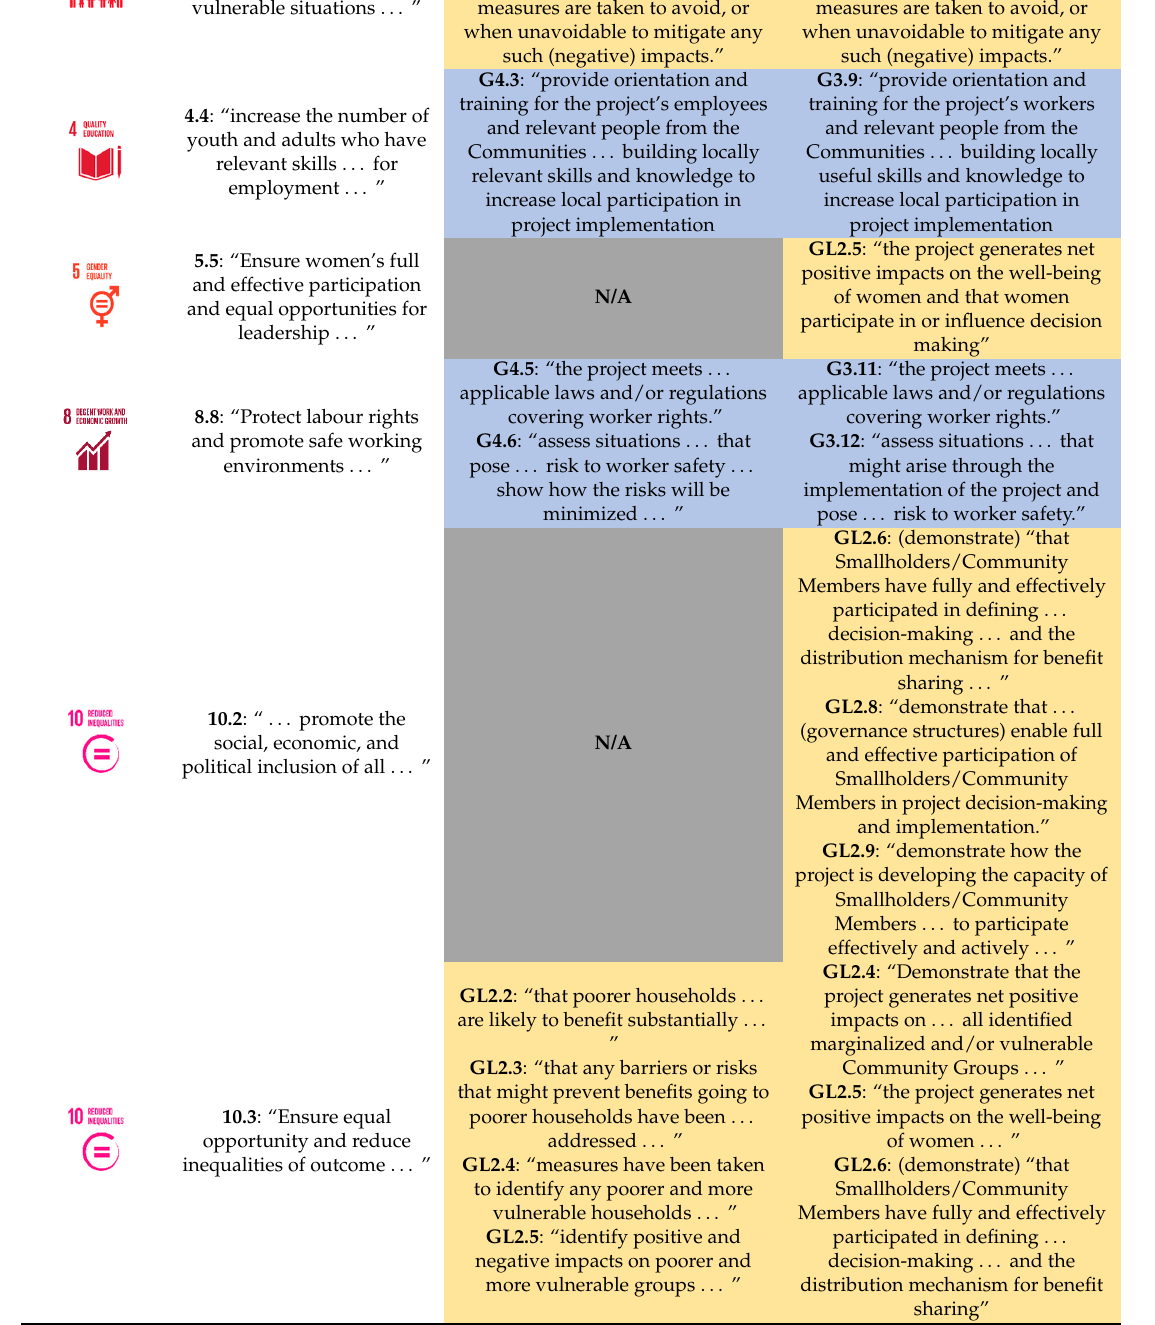
0 = not targeted; 1 = insufficient info; 2 = monitoring variable identified/variables are being monitored; 3 = evidence of monitoring and